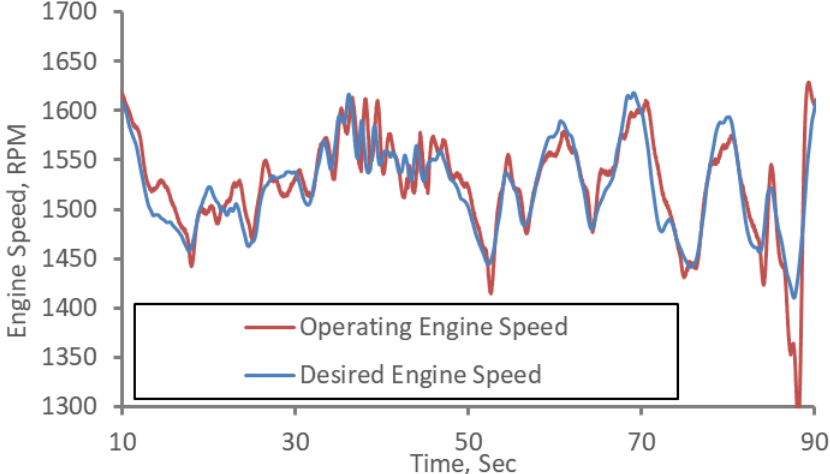
Figure 20. Measured engine speed and desired engine speed during plowing operation using the control system.